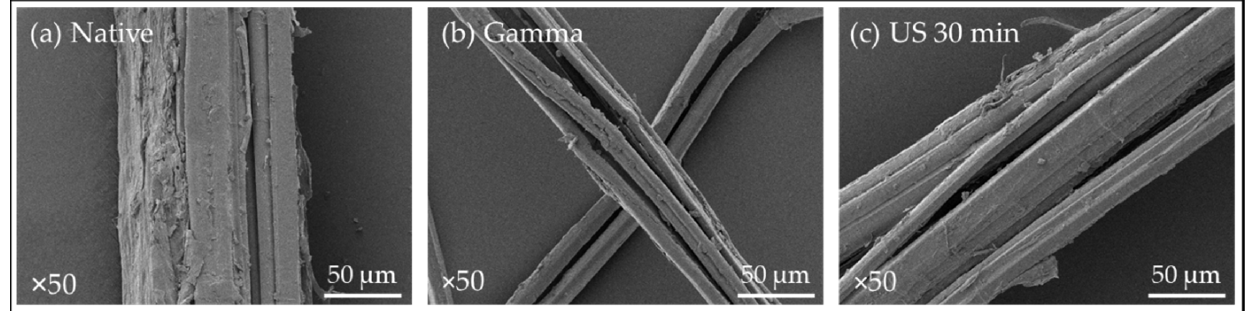
Figure 5. SEM observations (×50) of tows ( a ) Native; ( b ) Gamma; ( c ) US 30 min.